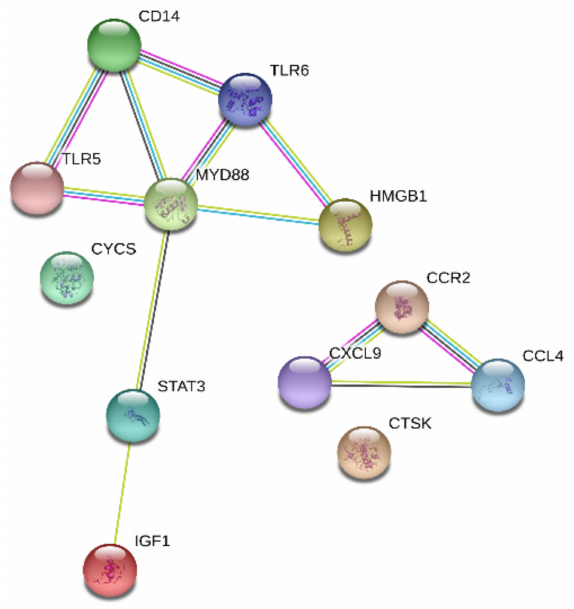
Figure 5. Search Tool for the Retrieval of Interacting Genes/Proteins (STRING) analysis of the relationship between 12 choosed